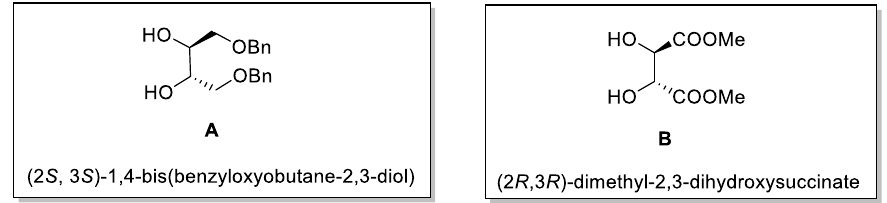
Figure 2. Optically active 1,2-diol as a chiral auxiliary .